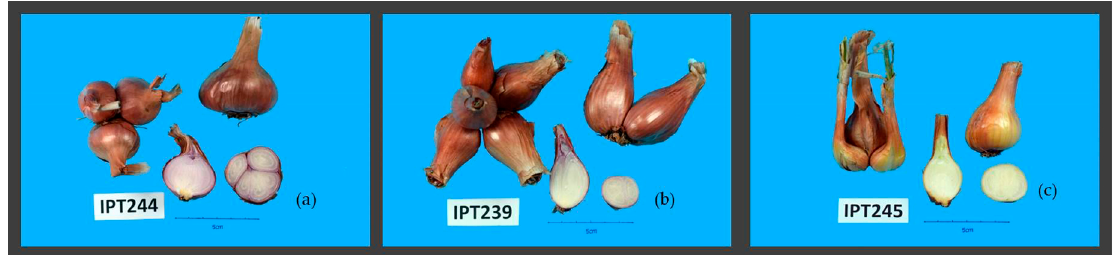
Figure 3. Diversity among A. cepa Aggregatum group species accessions bulb images. Broad oval bulb shape in potato onion type ( a ); ovate, pear-shaped bulbs in shallot type ( b , c ); white bulb flesh and yellow tunic color ( c ). The number in the figure represents the accession code assigned in the ex situ collection at IPTPO.